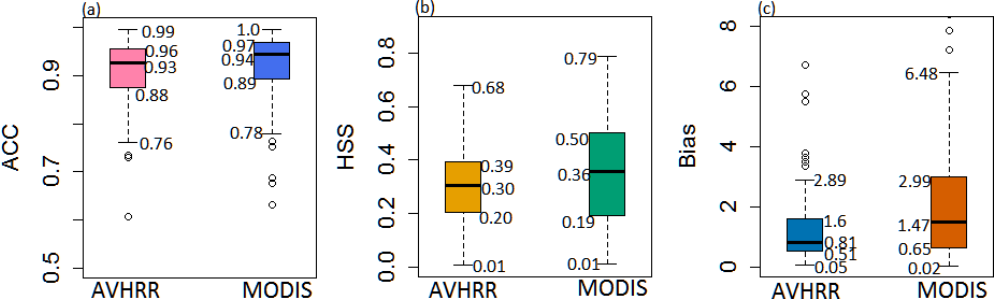
Figure 6. The boxplots of ACC (a) , HSS (b) , and Bias (c) for AVHRR raw and MODIS snow data throughout the sites. The numbers around the plots indicate the minimum, lower quartile, median, upper quartile, and maximum of the